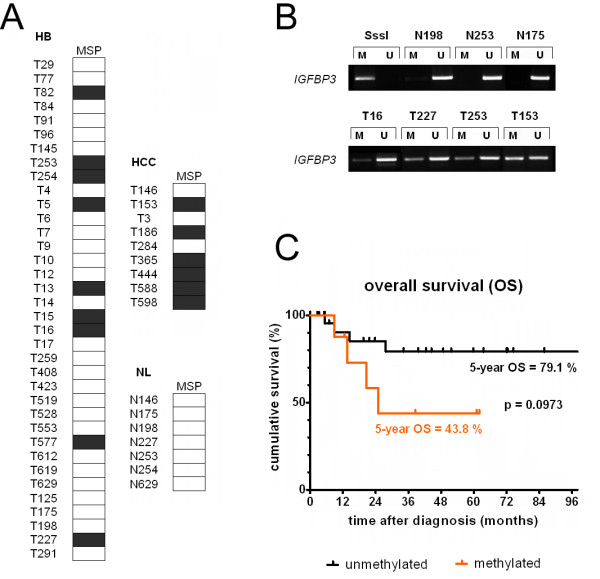
(A) Methylation status of the IGFBP3 promoter in pediatric liver cancers. Summary of the analyses of the IGFBP3 methylation status in the 36 hepatoblastomas (HB), 9 pediatric hepatocellular carcinomas (HCC), and 7 normal pediatric liver samples (NL), as determined by MSP. The black boxes represent the detection of methylated alleles, and the white boxes depict unmethylated alleles. (B) Methylation-specific PCR (MSP) of pediatric liver cancers. The promoter region of the IGFBP3 gene was analyzed for methylated CpG sites by MSP using bisulfite-treated genomic DNA from pediatric liver tumors (T) and normal liver tissue (N). Representative images of the MSP experiments are shown, revealing PCR products for unmethylated (U) and methylated alleles (M). In vitro methylated DNA (SssI) was used as a positive control for methylated alleles. (C) Overall survival (OS) stratified by methylation status. OS was calculated as the time from diagnosis to death from disease and is plotted for 8 HB patients with (orange line) and 25 without (black line) IGFBP3 promoter methylation over a period of 100 months. Statistical significance was calculated using Mantel-Cox test.